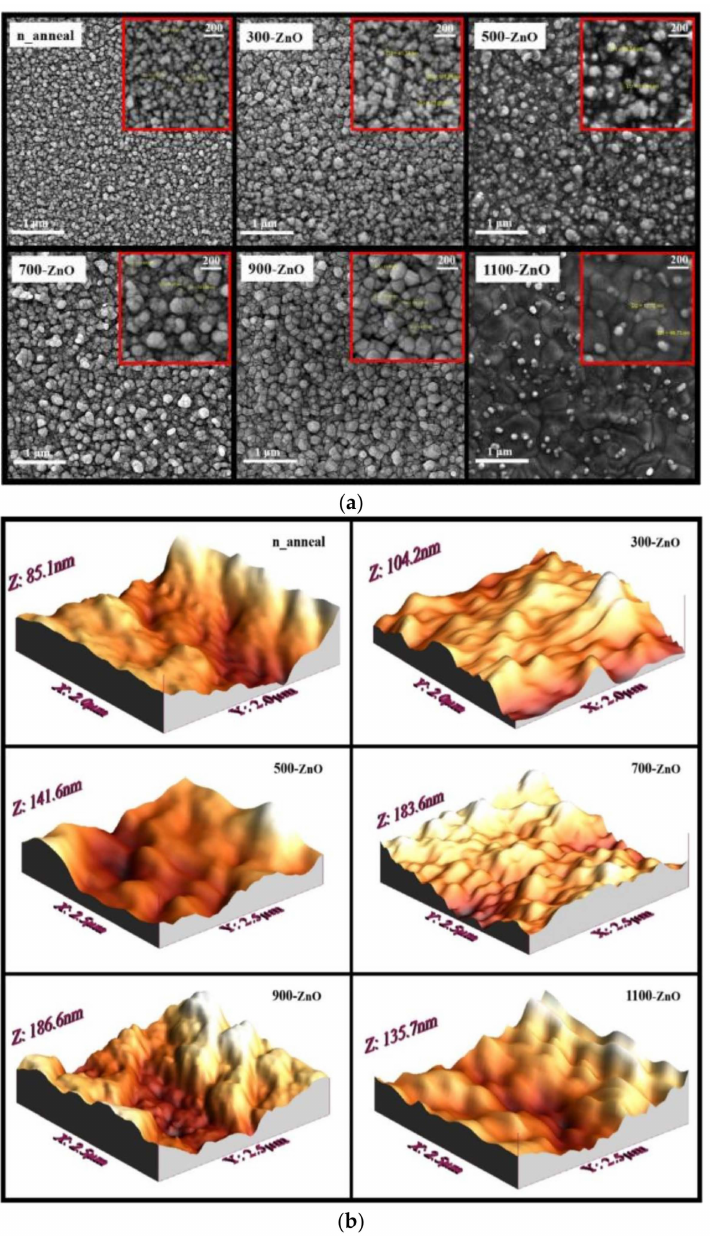
Figure 10. ( a ) SEM images of Zn and ZnO thin films annealed at the temperatures of 300, 500, 700, 900, and 1100 ◦ C [85]. ( b ) AFM images of Zn and ZnO thin films annealed at different temperatures